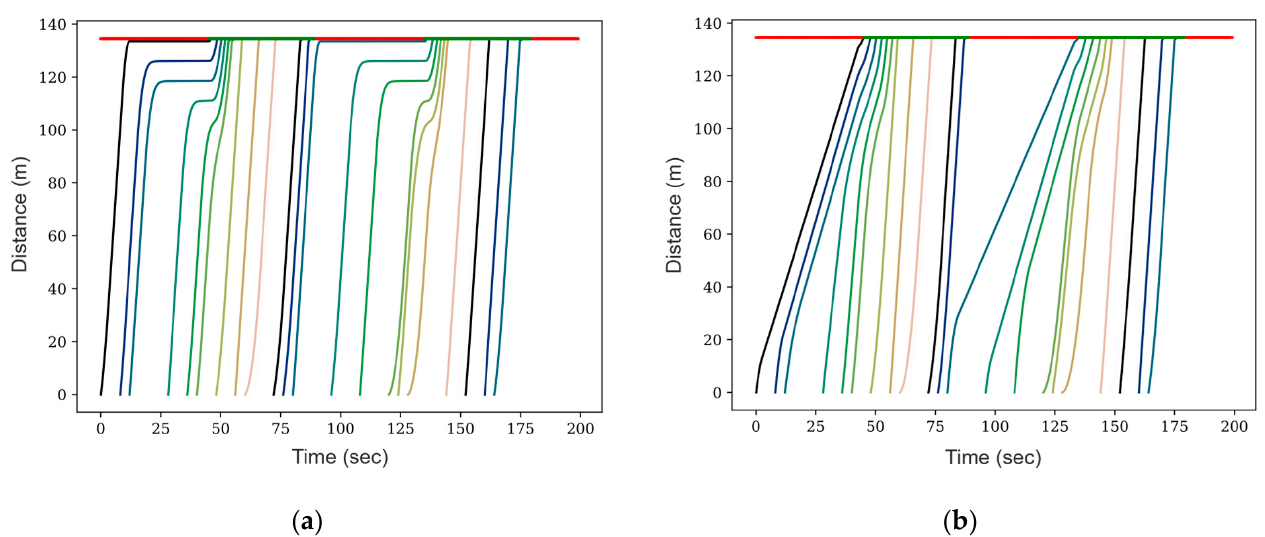
Figure 2. Time-space vehicle trajectories: ( a ) Trajectories of human-driven vehicles; ( b ) Trajectories constructed using the Shooting Heuristic algorithm.